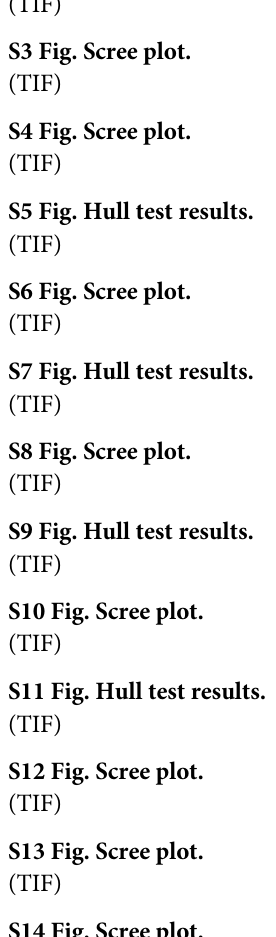
S2 Fig. Hull test results. (TIF) S3 Fig. Scree plot. (TIF) S4 Fig. Scree plot. (TIF) S5 Fig. Hull test results. (TIF) S6 Fig. Scree plot. (TIF) S7 Fig. Hull test results. (TIF) S8 Fig. Scree plot. (TIF) S9 Fig. Hull test results. (TIF) S10 Fig. Scree plot. (TIF) S11 Fig. Hull test results. (TIF) S12 Fig. Scree plot. (TIF) S13 Fig. Scree plot. (TIF) S14 Fig. Scree plot. (TIF) S1 Table. Definitions of factors from previous studies. a Substituted for “+ stingy”. b Substi- tuted for “+ bold”. c Substituted for “+ cooperative”. d Substituted for “+ cool”. e Substituted for “ − dependent”. S2 Table. Congruence coefficients for comparison of varimax- and promax-rotated struc- tures. S3 Table. Pattern matrix from the first-order factor analysis of ratings on the Hominoid Personality Questionnaire. N = 128. Soc = Sociability, Dom = Dominance, Imp = Impulsiveness, Opn = Openness, Neg = Negative Affect, h 2 = communalities. Factors extracted using a maximum likelihood estimation and rotated using the varimax procedure. Factor loadings greater than or equal to |0.4| are in bold. S4 Table. Pattern matrix from the factor analysis of residualized ratings. N = 128. Factors were not assigned labels. h 2 = communalities. Factors extracted using a maximum